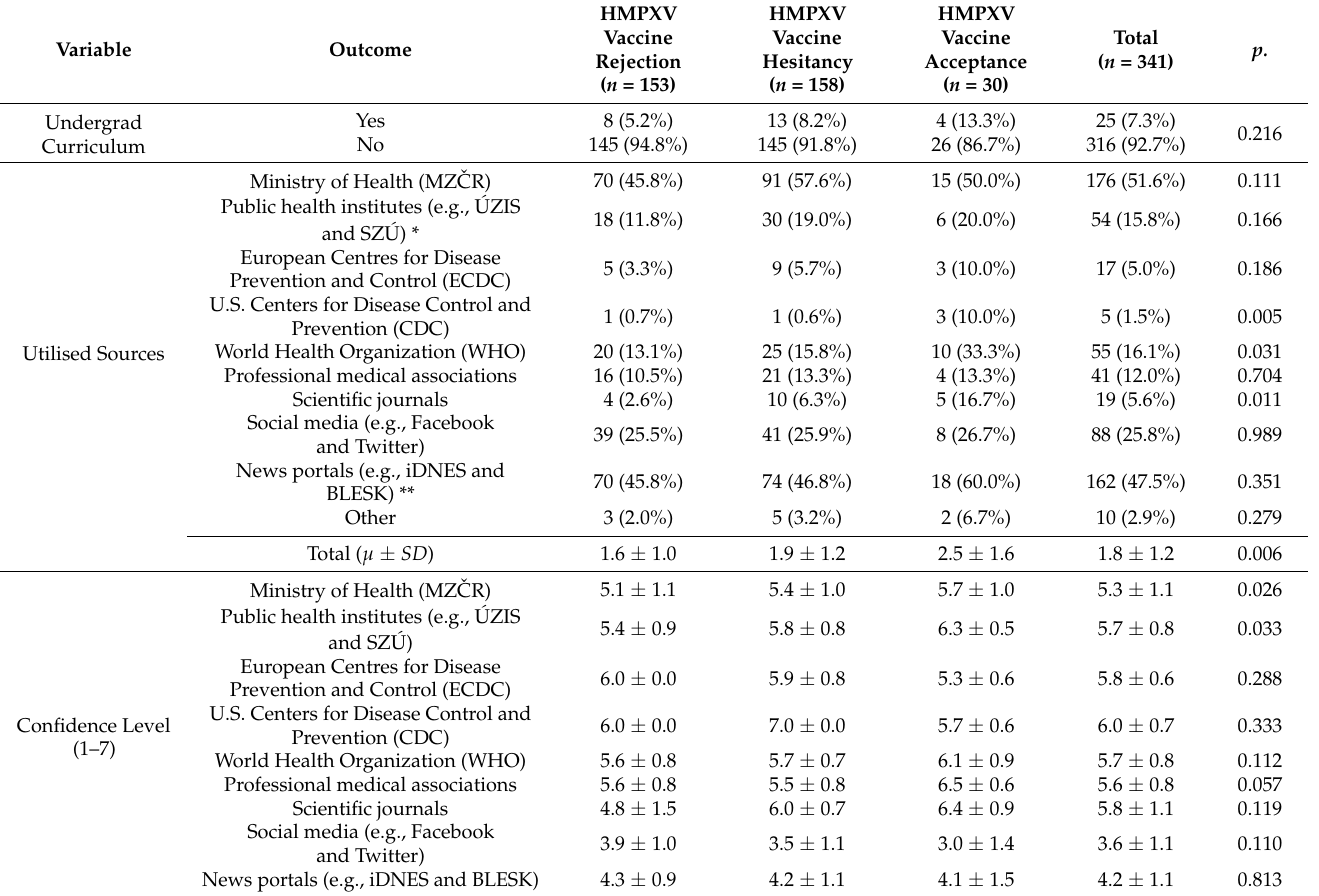
Table 3. Information sources utilised by Czech HCWs responding to the HMPXV survey, September 2022 ( n =